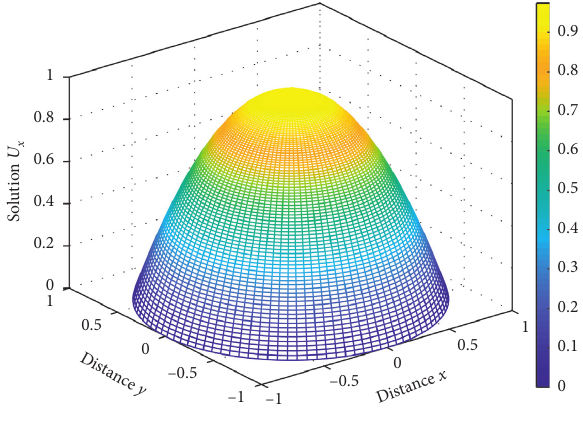
Figure 6: The exact